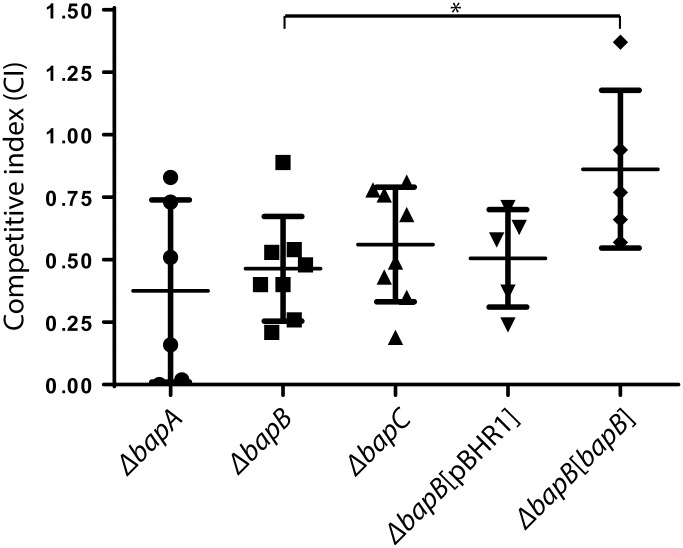
Competitive in vivo growth indices for each of the ΔbapA, ΔbapB and ΔbapC mutant strains and the ΔbapB[pBHR1] and ΔbapB[bapB] complemented strains compared to the wild-type strain.Each point on the graph indicates the competitive index (CI) measured in a single mouse. The horizontal marks show the average CI ± 1 SEM. *P < 0.05.